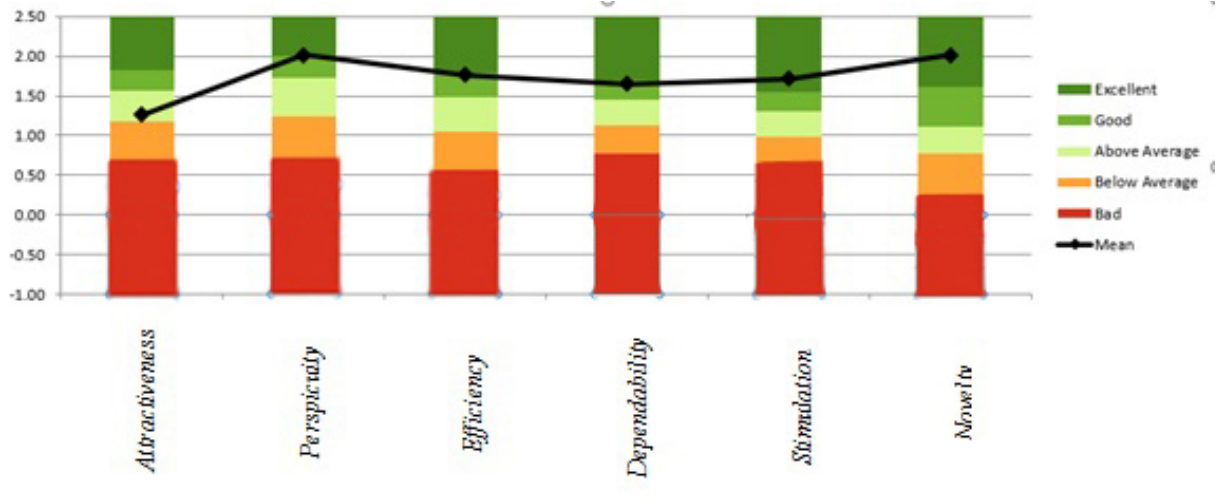
Figure 6. Comparison chart of average mobile app system measurements with previous studies.